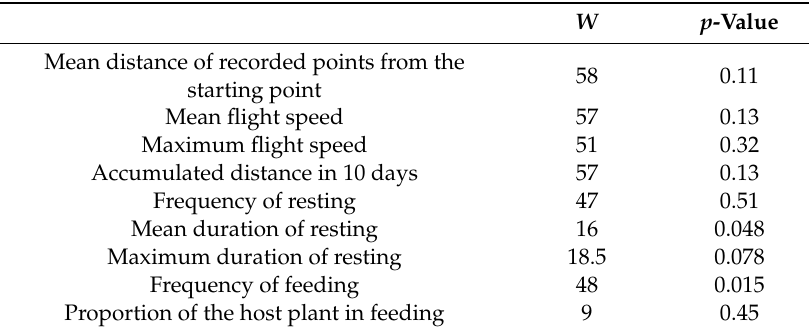
Table A2. Values of the U test between sexes in Z. m. argia